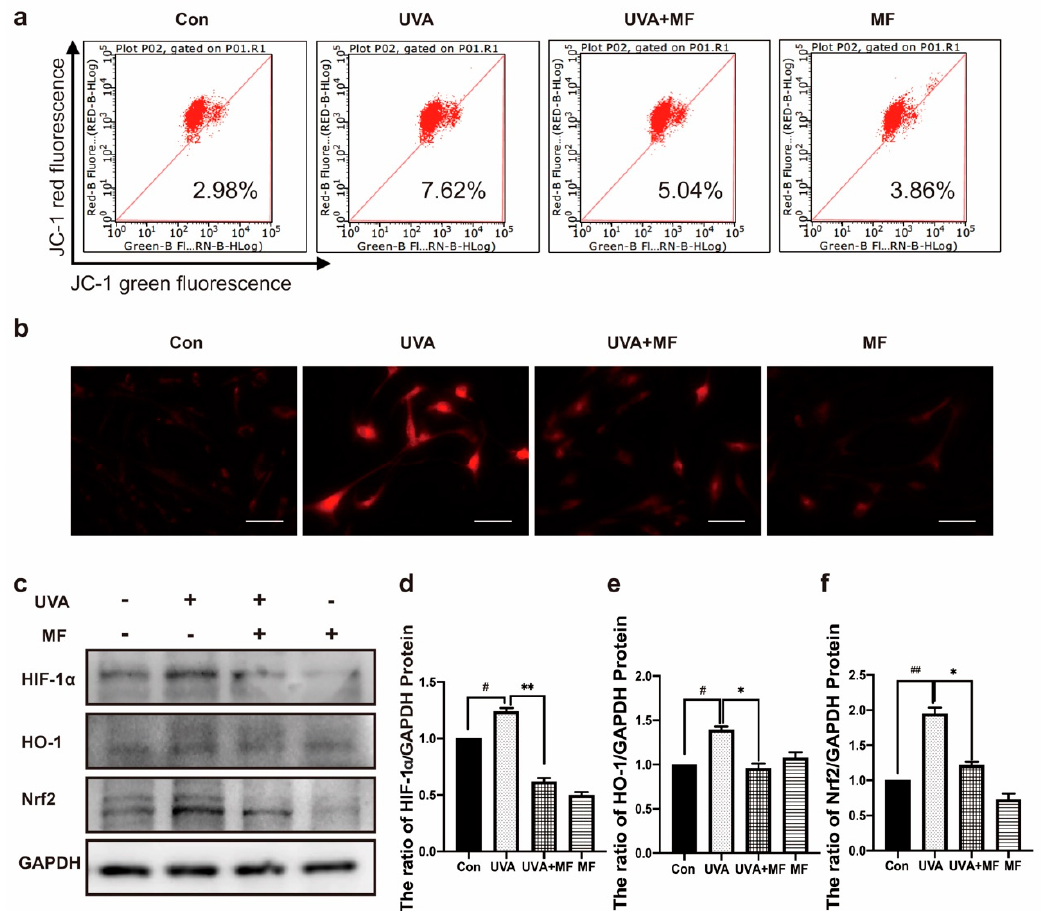
Figure 4. Metformin reduces UVA-induced oxidative stress. ( a ) Cells were treated with UVA alone or in combination with 100 μ M metformin. Mitochondrial membrane potential was detected by flow cytometry. ( b ) Cells were treated with UVA alone or in combination with 100 μ M metformin. Mitochondrial ROS generation was detected by MitoTracker Red CMXRos under fluorescence microscope (200×). ( c − f ) Cells were treated with UVA alone or in combination with 100 µ M metformin, the protein levels of HIF − 1 α , HO − 1, and Nrf2 were measured by western blot. Data are presented as mean ± SD, n = 3. # p < 0.05, ## p < 0.01 vs. control cells, * p < 0.05, ** p <0.01 vs. UVA-treated cells.